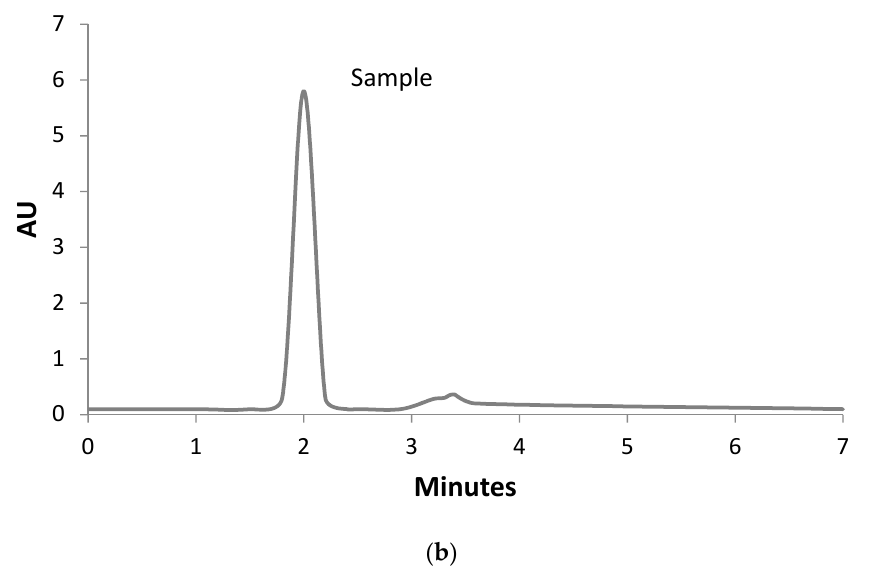
Figure 6. HPLC chromatogram of biovanillin ( a ) standard ( b ) sample.